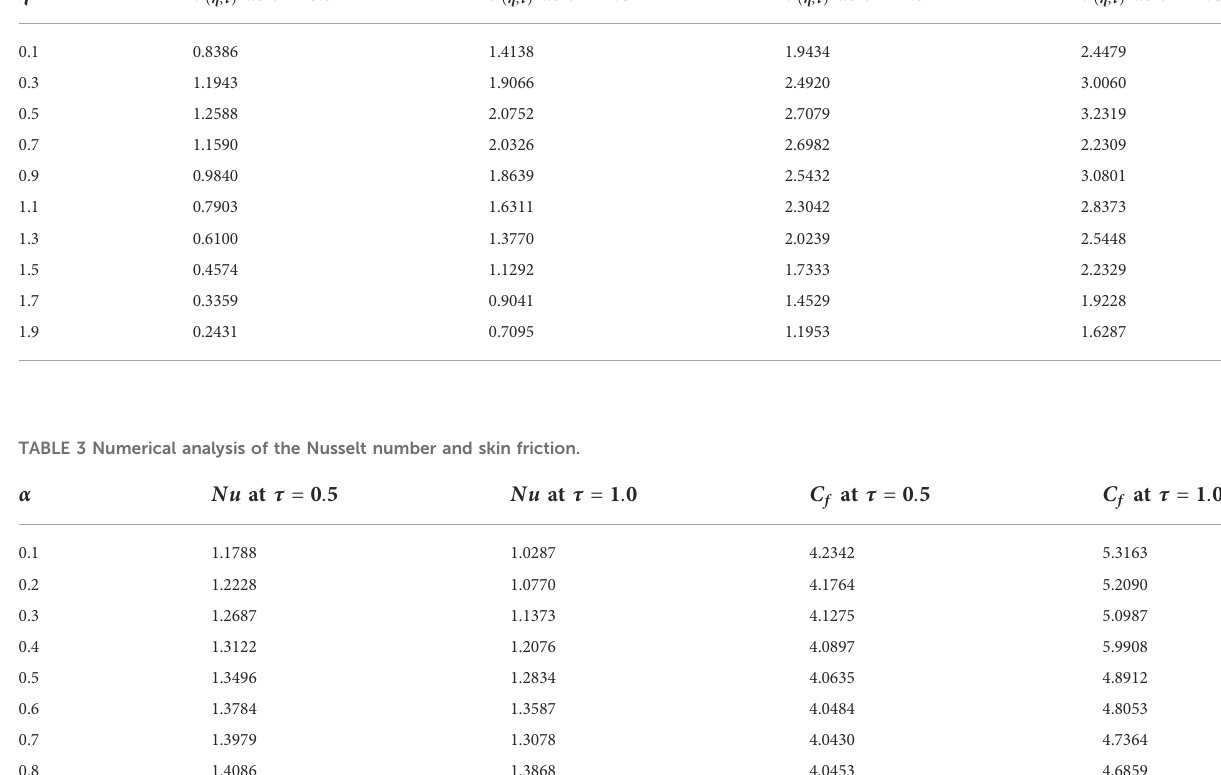
at τ (cid:3) 0 . 5 v ( η , τ )